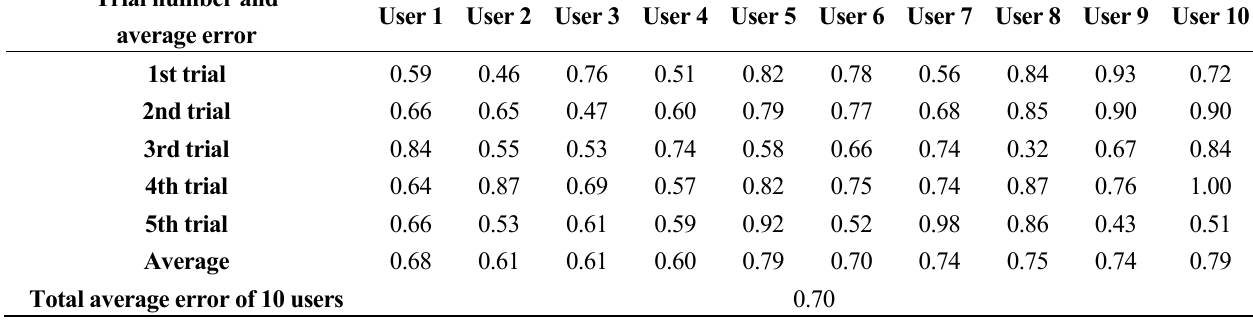
Table 4. The errors in gaze detection for cases where the users were wearing glasses (units: °). Trial number and average